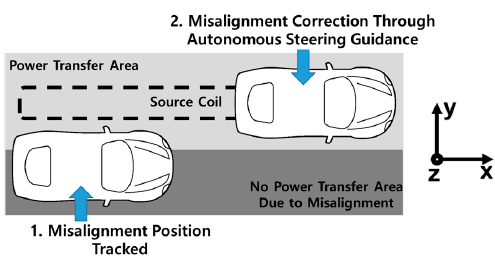
Figure 2. Concept of autonomous vehicle tracking and guidance to reduce degraded power transfer in a DWC system.